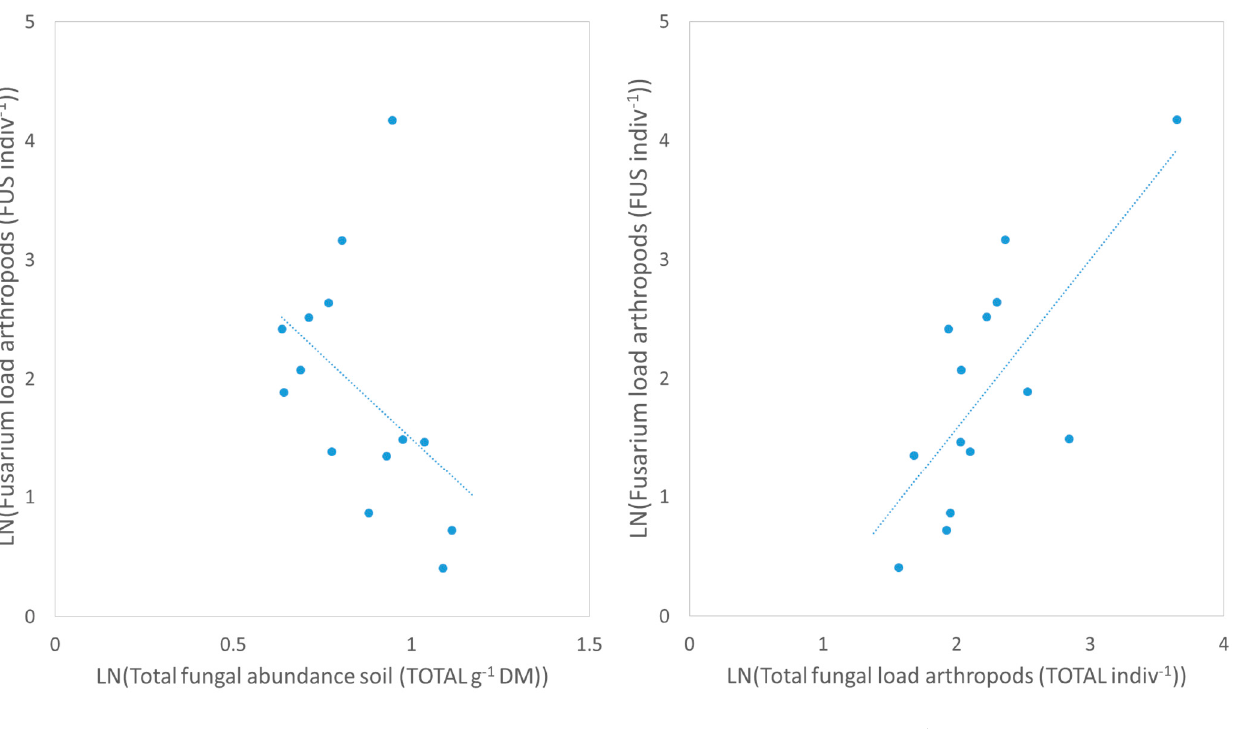
Abundances in SOIL and Litter The Fusarium load on the body surface of arthropods correlated significantly and negatively with the total fungal abundance in the soil (r sp = − 0.61, p = 0.03, Figure 2a) and significantly and positively with the total fungal load on the arthropods (r sp = 0.78, p < 0.001; Figure 2b). Arthropods with a high total fungal load also showed a high Fusarium load. No other significant correlations were detected between total fungal and Fusarium abundance or between fungal loads of different substrates (Figure 3).